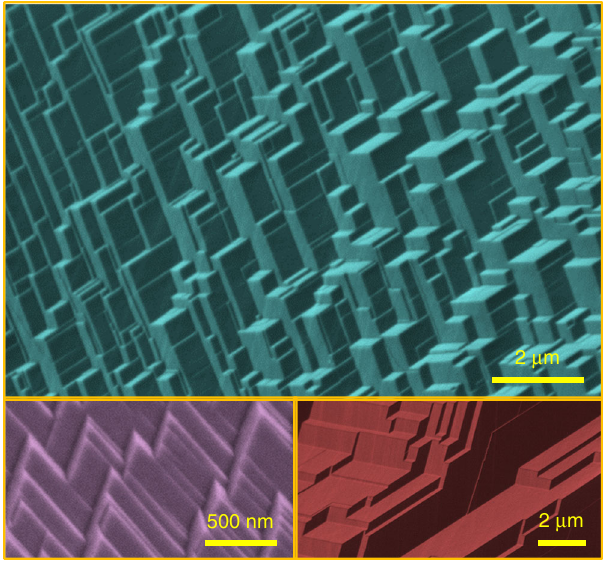
Fig. 1 Representative faceted grain boundaries (GBs) in S-doped Ni. Selected scanning electron micrographs of fractured grain surfaces, showing GB faceting. Additional images and speci fi c conditions